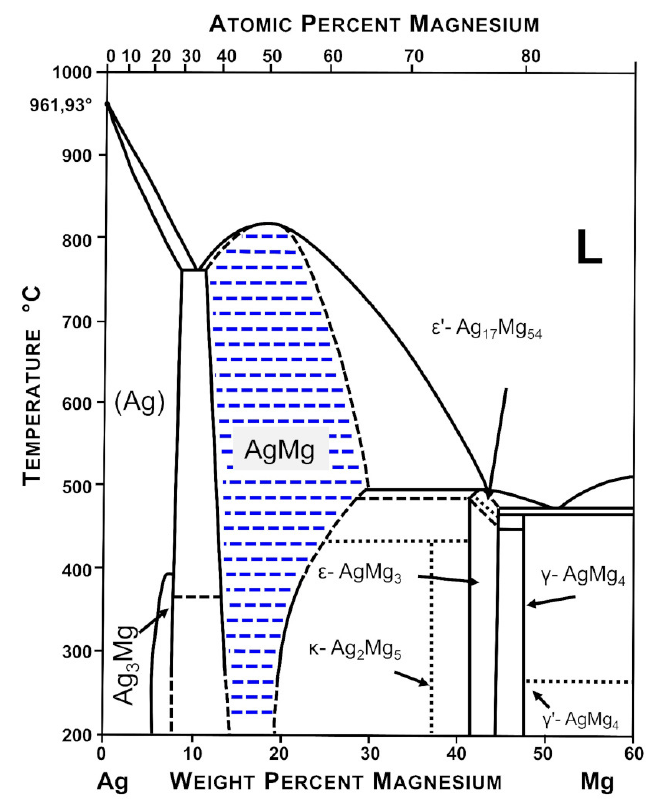
Figure 9. A part of the Ag-Mg phase diagram with the AgMg phase shown by the marked area [16,20–22]